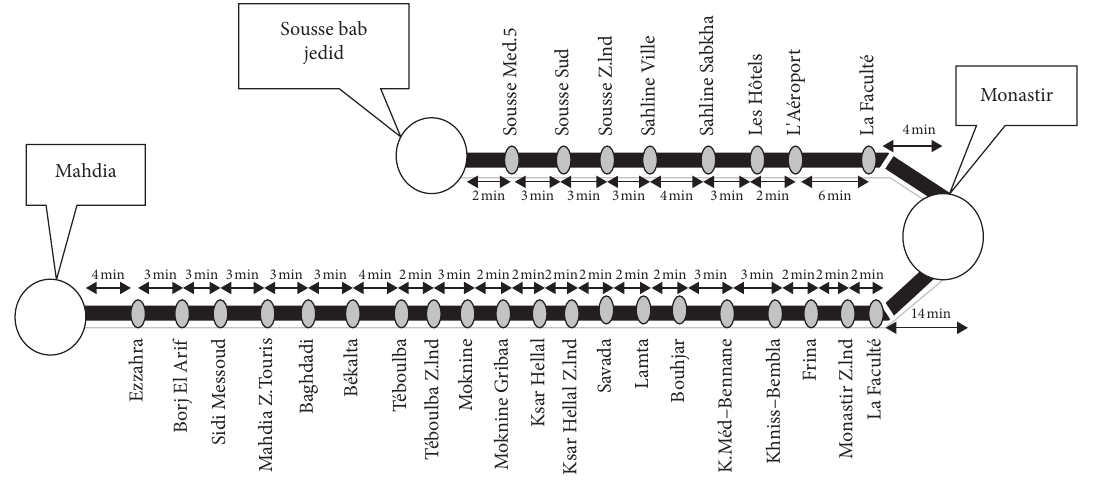
Figure 1: Stations of the Sahel